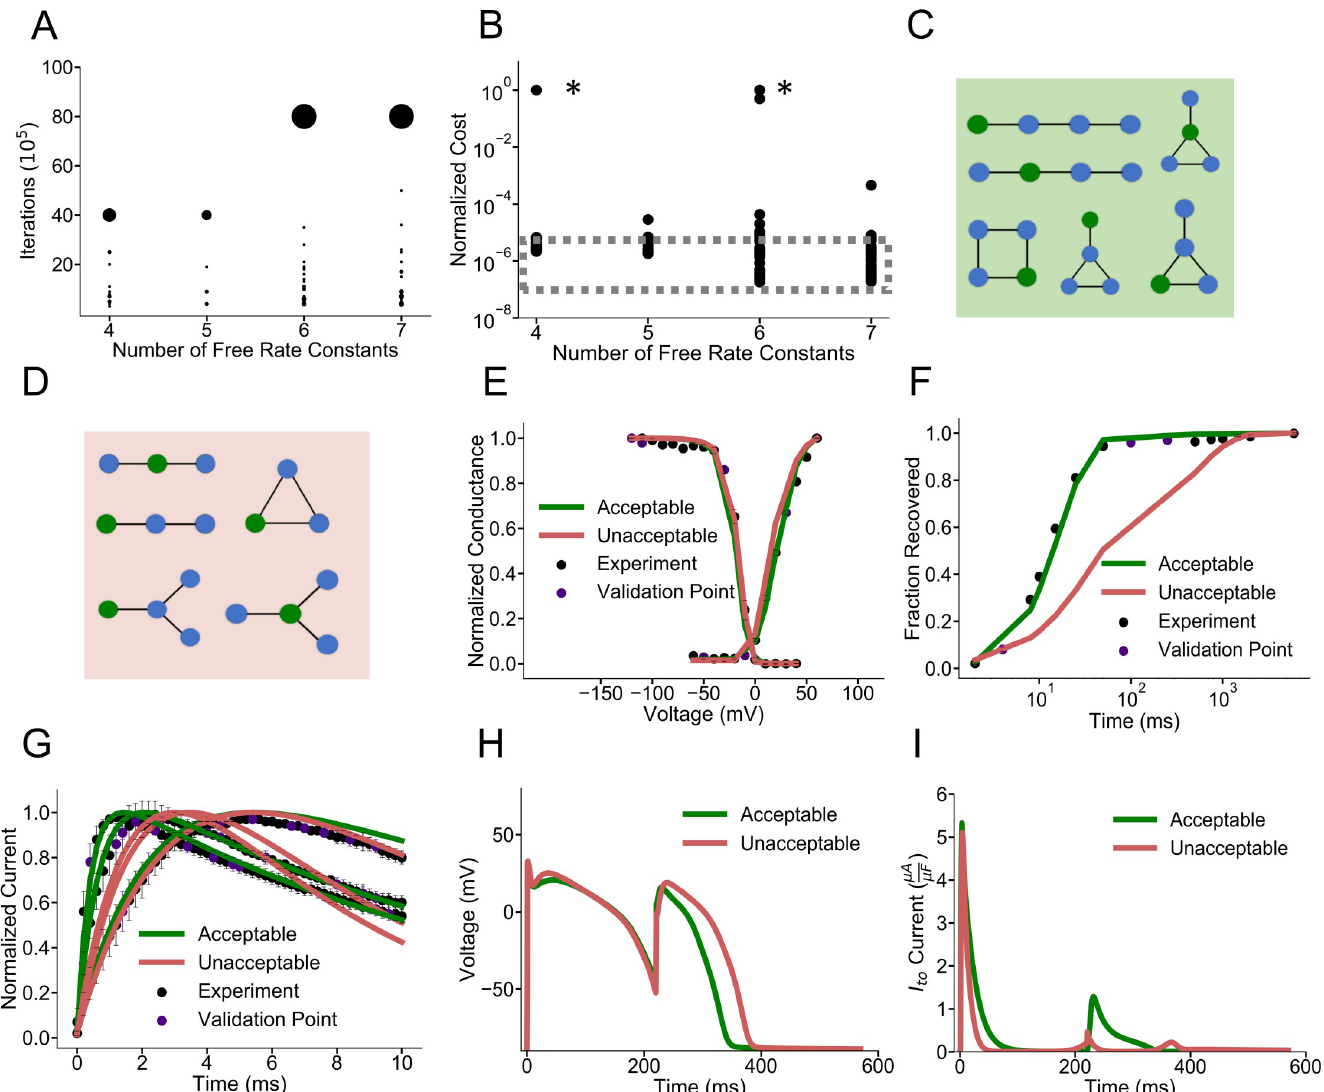
Fig 2. Identification of possible structures for the I to,f dataset. A) Optimization iterations completed as a function of free rate constants. Weighting of dots represent the frequency of models completing a specified number of iterations. Most models complete the generous maximum iteration limit (40,000,000) with 4 and 5 free rate parameters while few models complete less iterations due to early stopping from the overfitting criterion. Models with 6 and 7 free rate parameters may run for longer (maximum 80,000,000 iterations displayed) while a greater fraction of models are terminated early due to overfitting criterion. Data points include the multiple starting conditions for each model to reduce the dependence of the minimum solution on initial conditions B) Distribution of normalized costs for each model with multiple starts after completing optimization iterations as depicted in A . Especially bad Sobol starting conditions are asterisked. The absolute minimum costs are outlined in the dashed grey box. The point of diminishing returns is at 6 and 7 free rate constants. C) Topologies producing acceptable fits and D) unacceptable fits for I to,f . Acceptable fits include models with four states and sufficient connections to separate the activation and inactivation domains. E-G) Representative models fits for steady state activation, inactivation, recovery from inactivation and current traces for models in the acceptable and unacceptable model categories. Unacceptable models generally have very slow recovery from inactivation. H) Simulated action potentials with representative acceptable and unacceptable I to,f currents under a S1-S2 protocol. I) Corresponding simulated I to,f currents under the S1-S2 protocol in A . Acceptable currents (green) and unacceptable currents (red) most differ in magnitude at around 200 ms into the S1 action potential with much less unacceptable I to,f currents. This corresponds with the slow recovery from inactivation depicted in F) where at ~200 ms the acceptable models have fully recovered while unacceptable models are only half